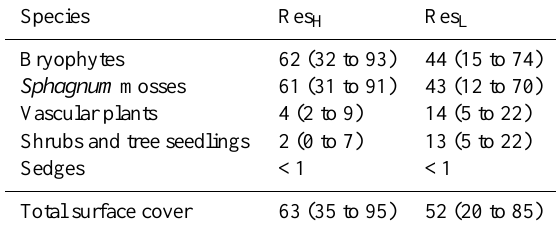
Table 3. Vegetation cover (%) inside the collars for greenhouse gas flux measurements in restoration treatments with high (Res H ) and low (Res L ) water table level. Total surface cover represents the area of bare peat surface re-colonized by vegetation; numbers in paren- thesis indicate the range among individual